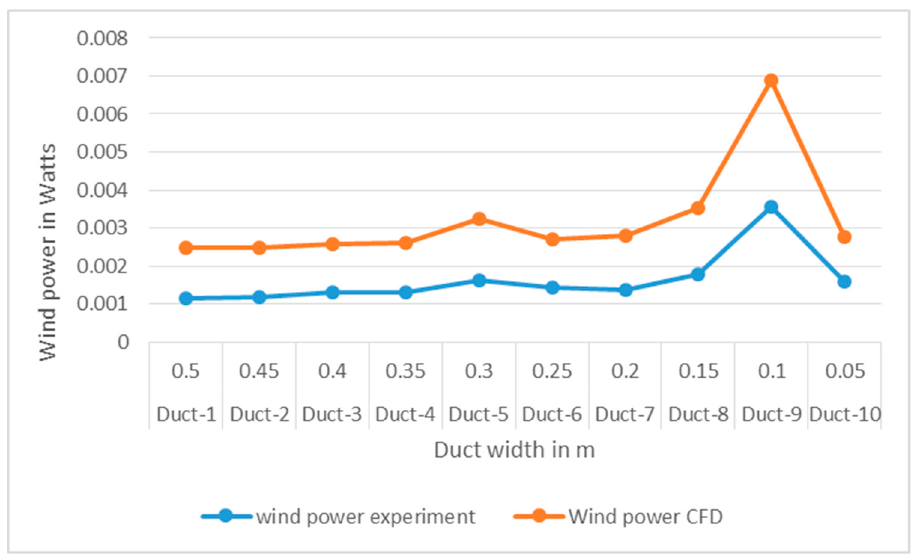
Figure 9. Kinetic power yields from the buoyancy wind speeds.